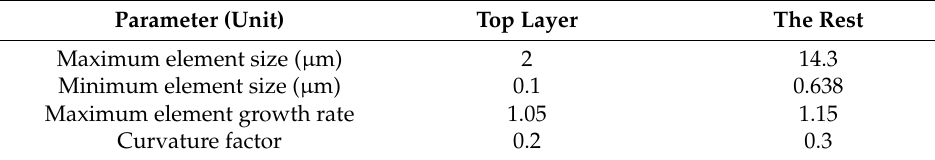
Table 5. Grid size